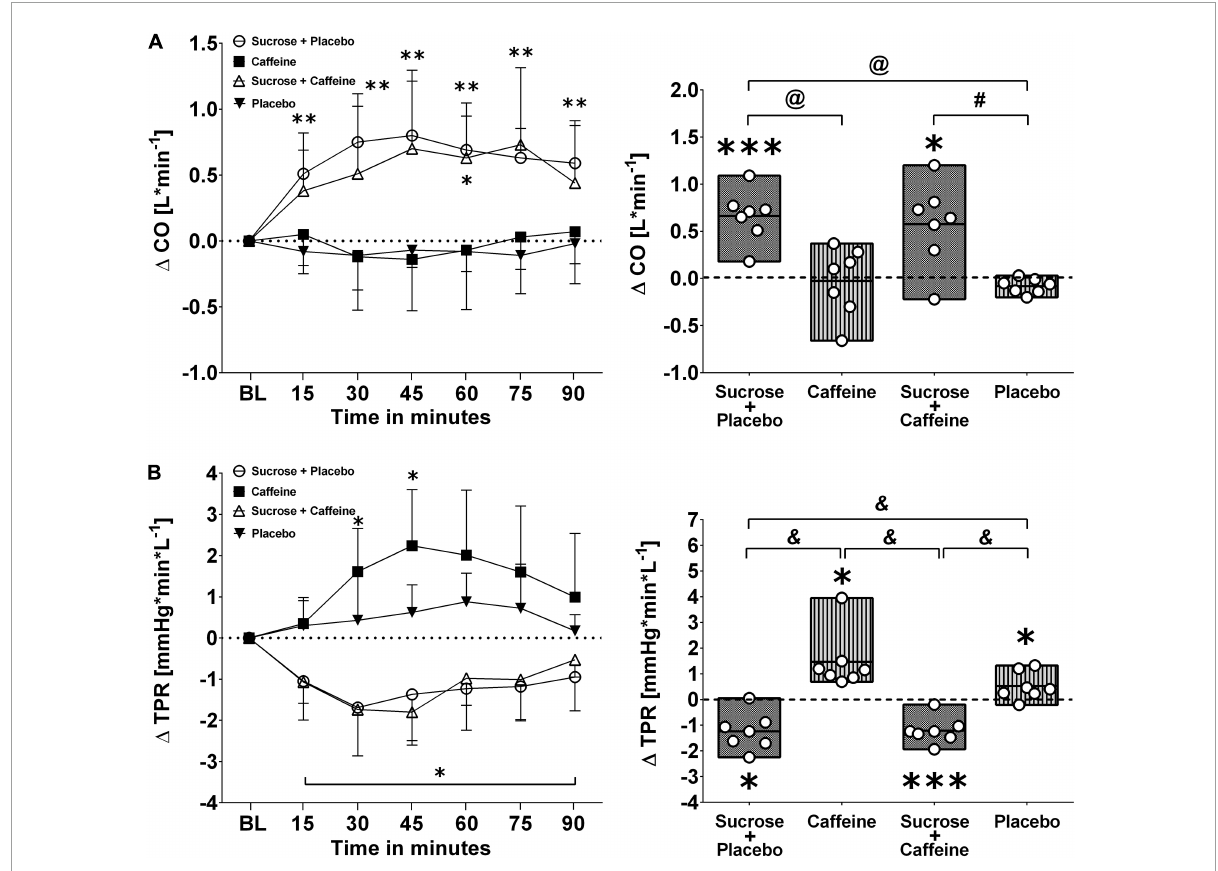
FIGURE3 Left panels (A,B) : Time course for changes in cardiac output (CO) and total peripheral resistance (TPR) in response to the four drinks. Each mean value (i.e., 15-min blocks) corresponds to the average over the respective interval that was subtracted by its baseline (BL) values. Data are presented as means ± standard deviation. Right panels (A,B) : Boxes (minimum to maximum values) represent individual mean responses (open circles) averaged over 90 min post-drink and subtracted by baseline values for each drink, respectively. In both panels, asterisks show statistically significant differences over time from baseline values (both panels) at ∗ p < 0.05, ∗∗ p < 0.01, and ∗∗∗ p < 0.005. For right panels only, # p < 0.05, @ p < 0.01, and & p < 0.005 represent statistically significant differences between responses to the drinks as analyzed by one-way repeated measures analysis of variance with Holm–Sidak’s post hoc